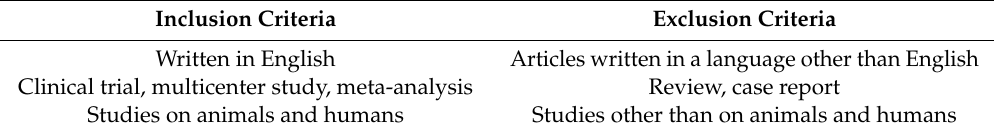
Table 1. Inclusion and exclusion criteria of